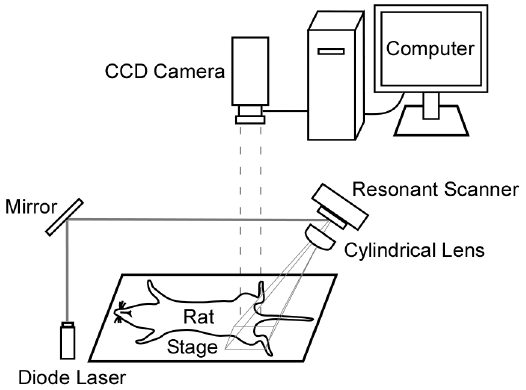
Figure 4. Schematic of fluorescent imaging system. The fluorescent imaging system was comprised of a laser unit, a resonant scanner, a cylindrical lens and a charge-coupled device camera and a